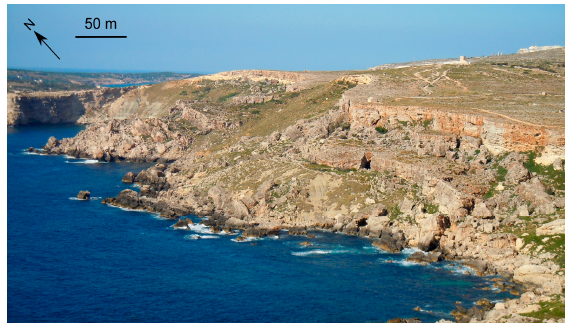
Figure 9. Rdum id-Delli—Rdum Majjiesa site seen from the south.